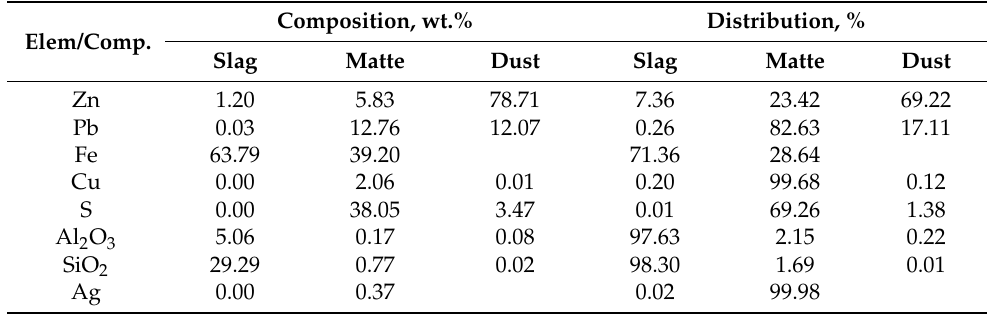
Table 9. Results of smelting tests, jarosite-PbAg sludge sulfidized with the addition of sulfur. Elem/Comp.